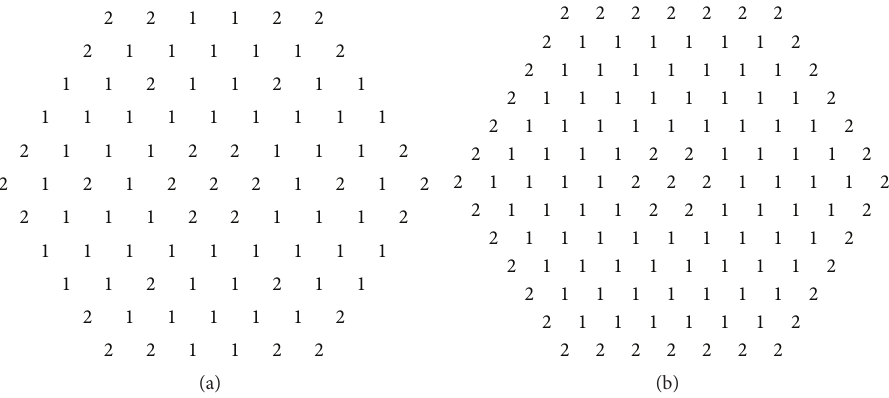
Figure 3: Arrangement schemes of fuel assemblies of the first and second type for small and large reactor cores: (a) small reactor core; (b) large reactor